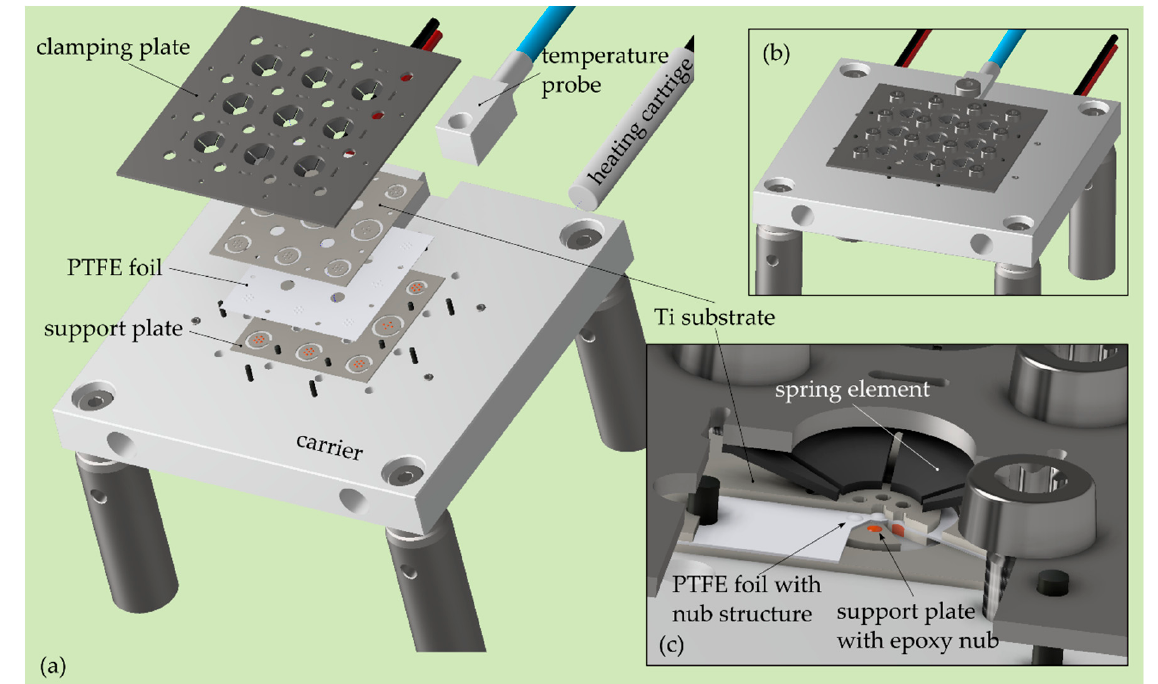
Figure 4. CAD drawings of the instrumented substrate carrier used for the filling process. ( a ) Exploded view showing the different plates for sealing and clamping of the substrate and the heating system of the carrier; ( b ) carrier with the substrate and heating system installed; ( c ) zoomed view on one sample of the substrate illustrates the sealing and clamping mechanism.